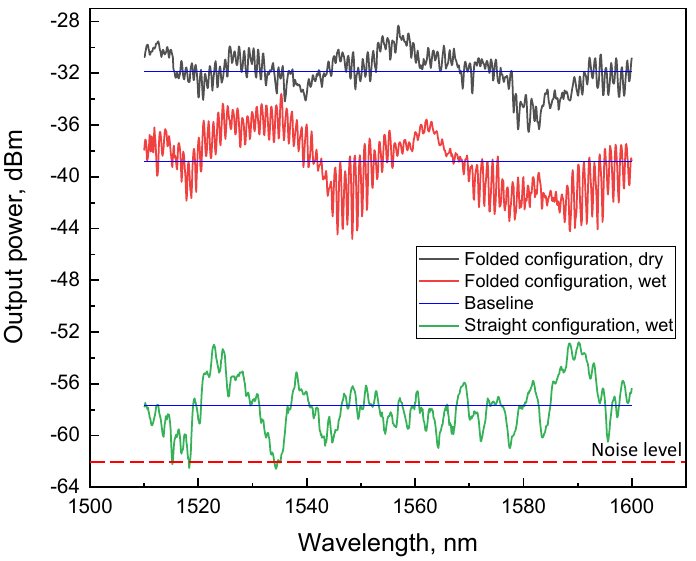
Figure 3. Comparison of transmission spectra in straight and folded configurations. Blue lines are the baselines corresponding to dry and wet states of both straight and folded